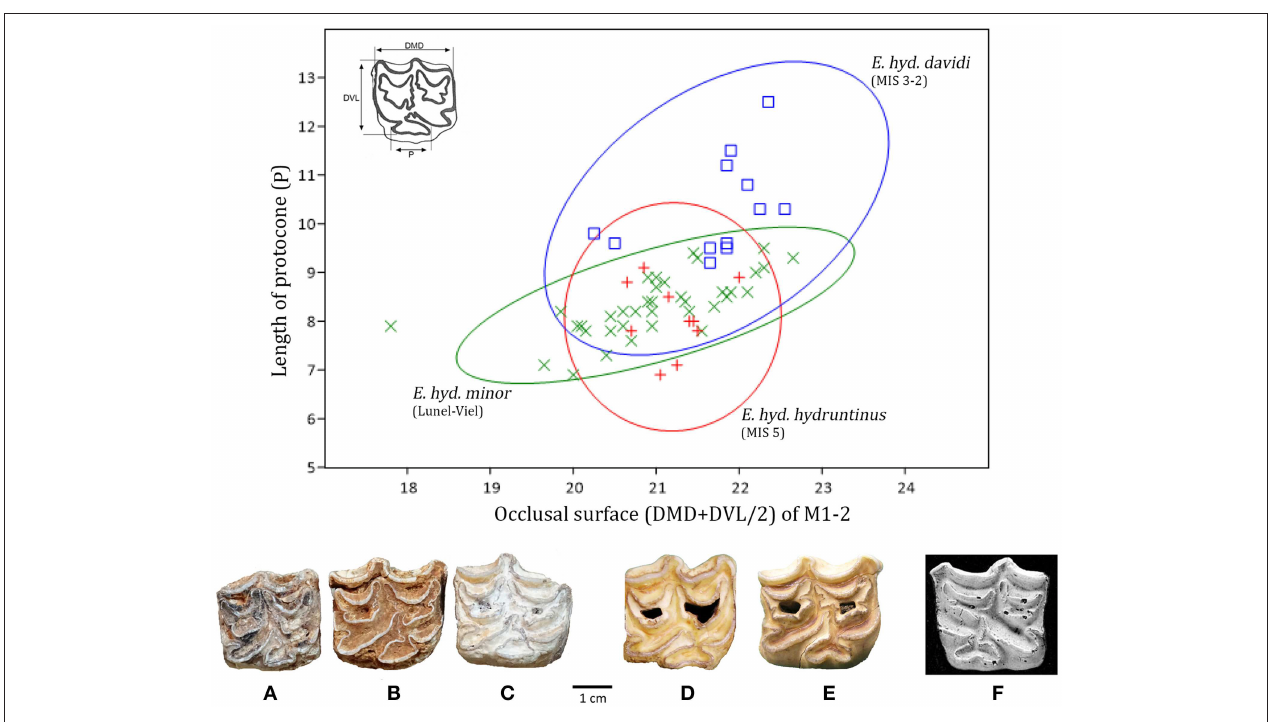
FIGURE 13 | Bivariate plot of protocone length vs. occlusal surface of M1-2. Occlusal surface: average occlusal dimension [(DMD + DVL)/2]. Confidence ellipsoid (95 %). Data: E. hydruntinus minor (Lunel-Viel); E. hydruntinus hydruntinus (Ramandils, MIS 5); E. hydruntinus davidi (Crouzade, Arquet, MIS 3 and Valorgues, MIS 2) (Boulbes, pers. data). Upper teeth of Equus hydruntinus . (A–C) right P3, P4, M1 from Ramandils cave ( E. h. hydruntinus ); (C, D) right M1 and P4 from Crouzade cave ( E . h. davidi ); F : right P4 of Equus graziosii (from Eisenmann,